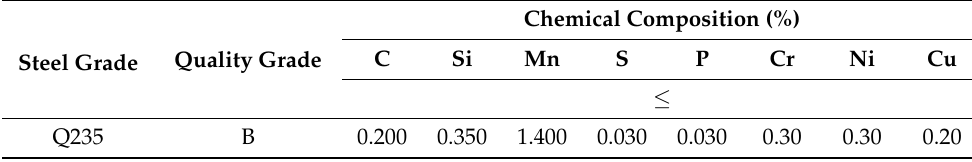
Figure 1. The infrared spectra of the four alcohol amines. Table 1. The chemical composition of Q235 carbon steel (melting